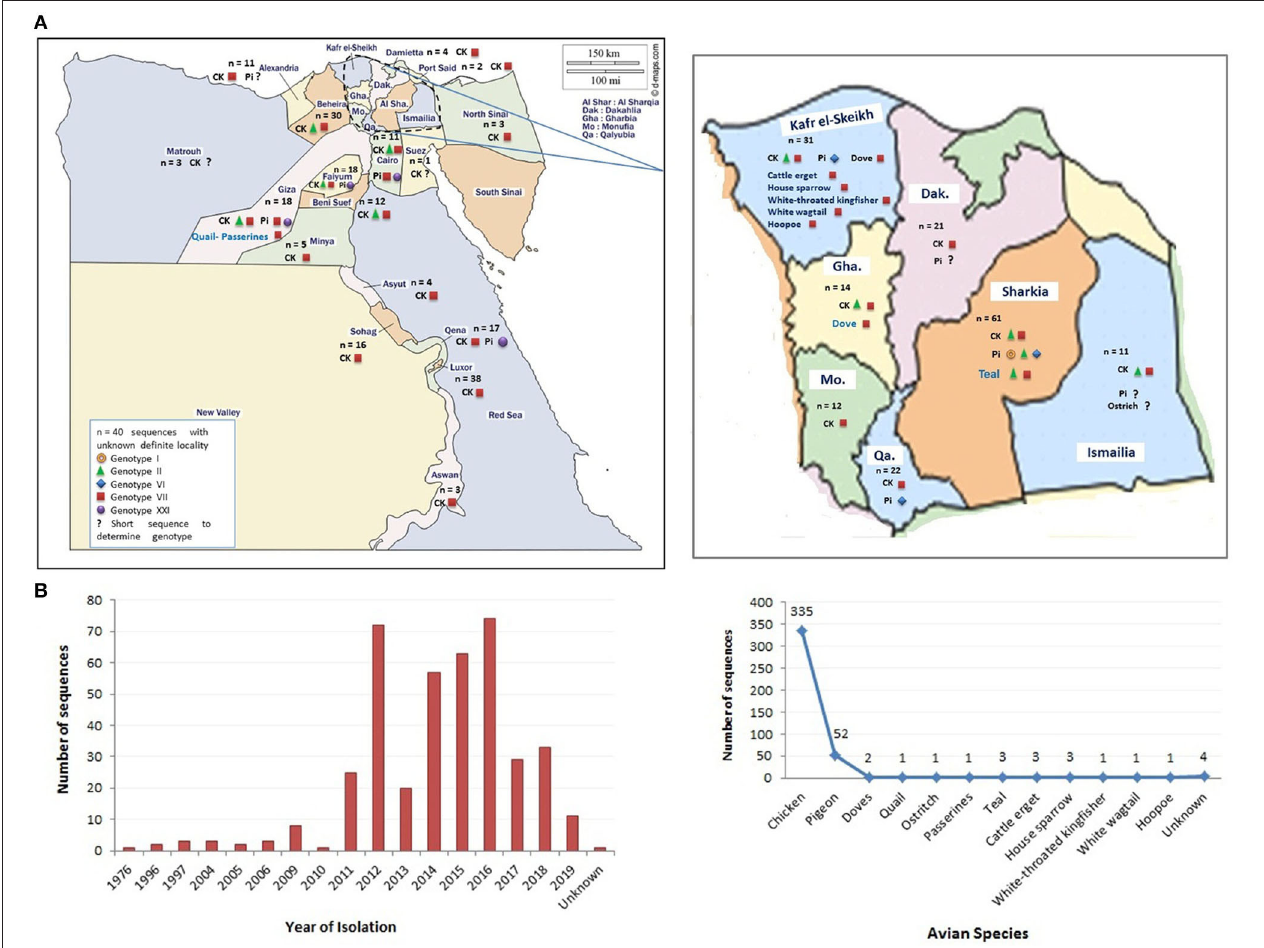
FIGURE 1 | The distribution of Newcastle disease virus (NDV) strains (sequences) in Egypt. (A) The geographical detection of NDV in different Egyptian provinces (data obtained from GenBank in early December 2020). (B) The grouping of detected NDV strains according to year of detection and species of origin. Color codes are indicated in the